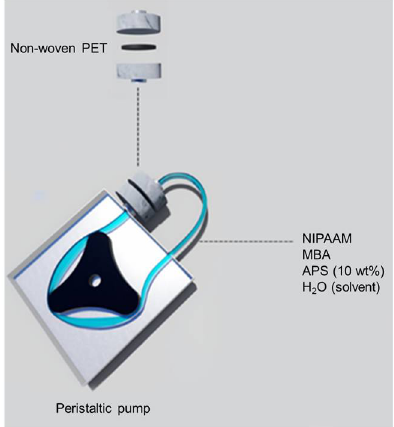
Figure 1. Circulation of reactive monomer solution through non-woven PET.